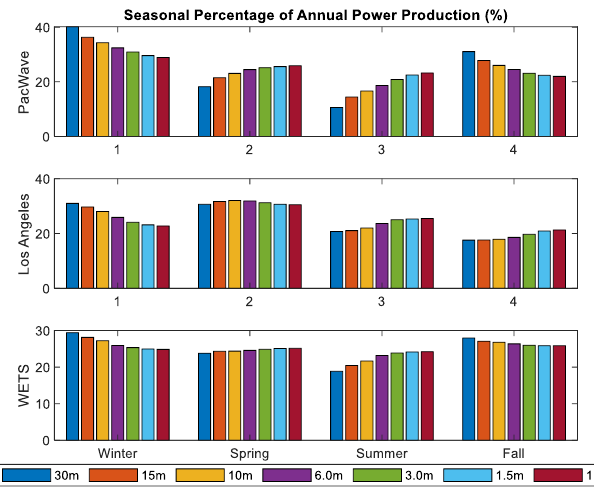
Figure 11: Percentage of annual power production per season and WEC size. (Winter: December, January, February; Spring: March, April, May; Summer: June, July, August; Fall: September, October,